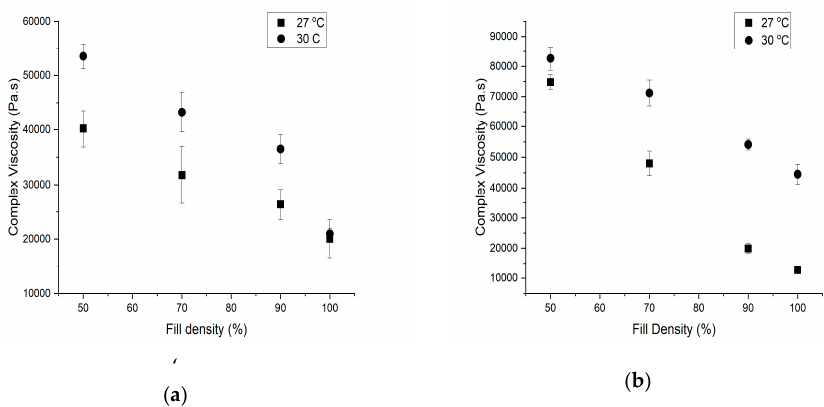
Figure 6. Complex viscosity values at different fill densities, temperatures, and ( a ) water butter ratios: 3:10 and ( b ) water butter ratio of 6:5. Values are mean ± standard deviation ( n = 3).